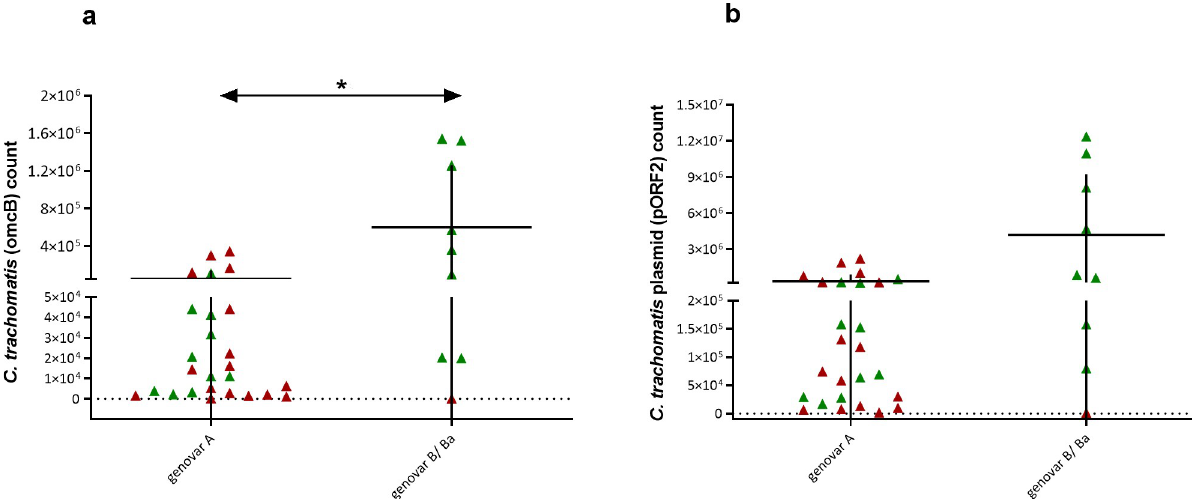
Fig 2. Bacterial loads and plasmid copy numbers for different Ct genovars. Scatter dot-plots show the mean Ct load (a) and plasmid copy number (pORF2) (b) in samples positive for the B/Ba genovars were significantly higher than those for genovar A. Samples from Moroccan children are marked in green and samples from Sudanese children are marked in red. The vertical lines indicate the error bars that express the standard deviations, and the horizontal lines indicate the means. Statistical significance is indicated as follows: � p = 0 � 017.